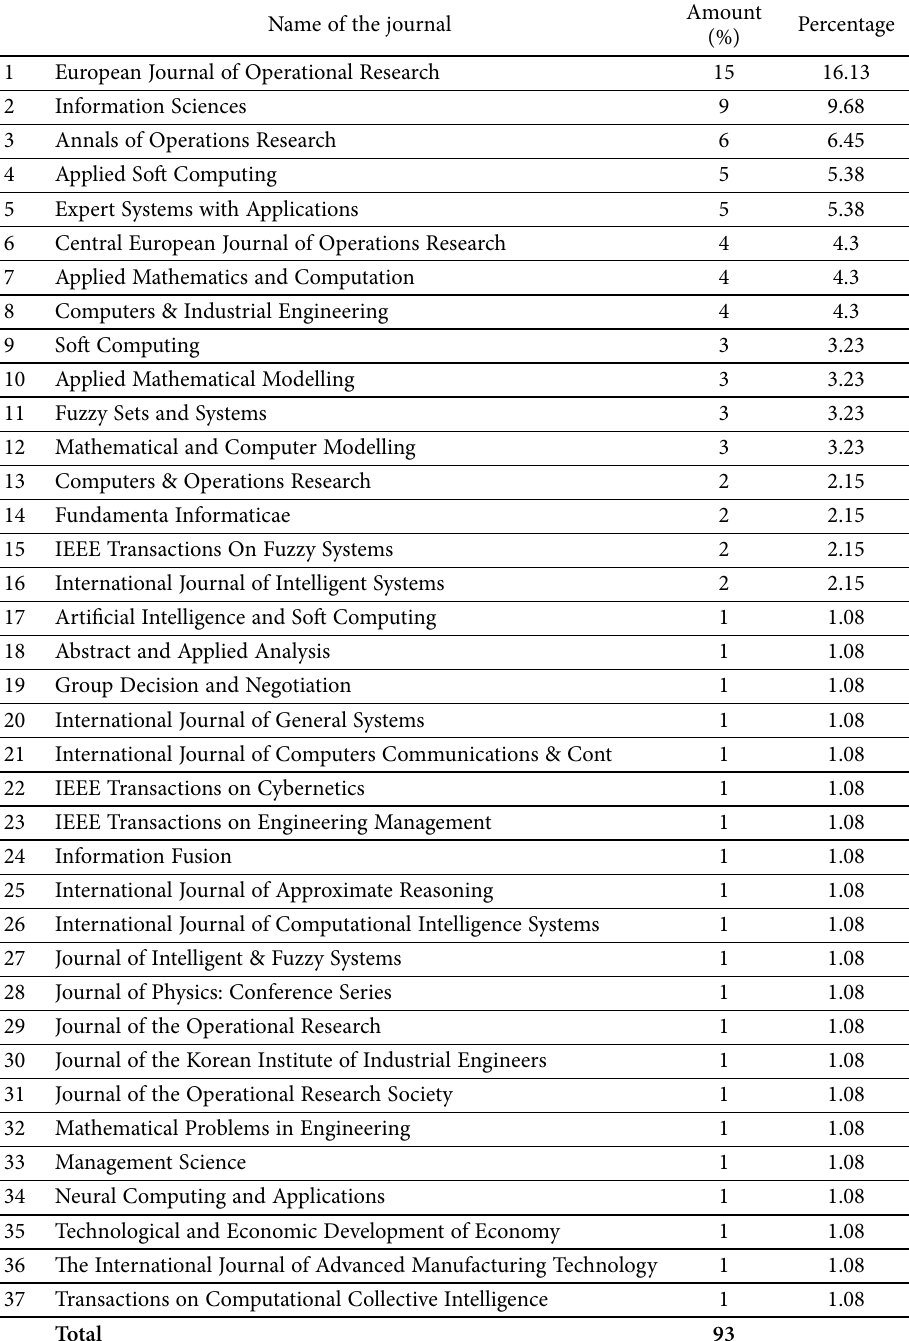
Table 1. Distribution of the selected articles by